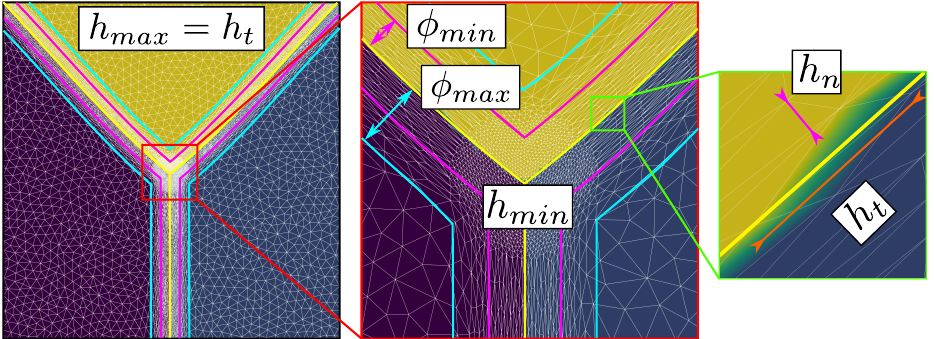
Figure 4. Illustration of the anisotropic mesh refinement